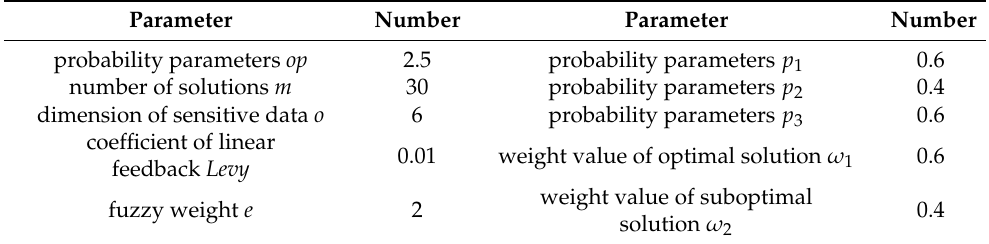
Table 6. Simulation parameters